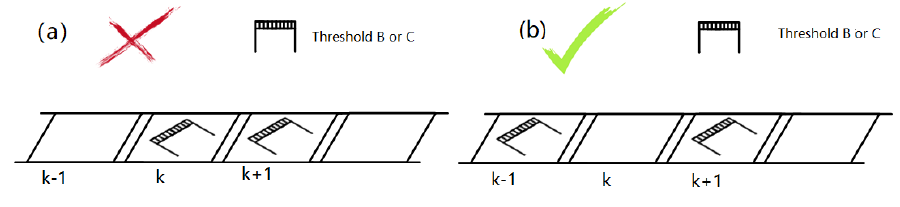
Figure 9. A reasonable arrangement of specific